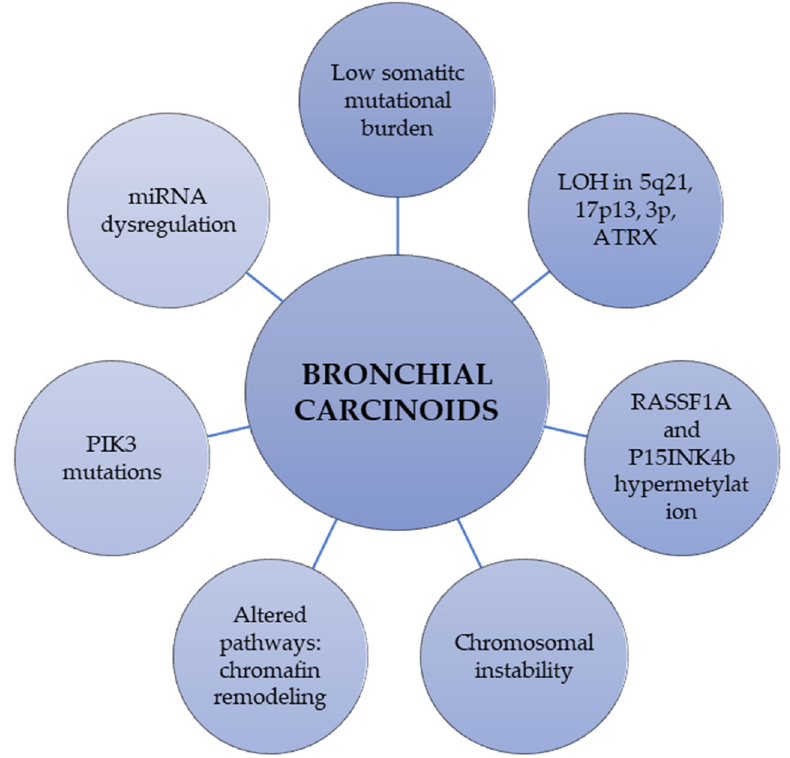
Figure 1. Overview of the most relevant molecular and genetic characteristics of bronchial carcinoids. ATRX: alpha thalassemia/mental retardation syndrome X-linked; LOH: loss of heterozygosity; RASSF1A: Ras association domain-containing protein 1; PIK3: phosphatidylinositol cinasa-3. Table 1. Molecular and genetic alterations in bronchial carcinoids.